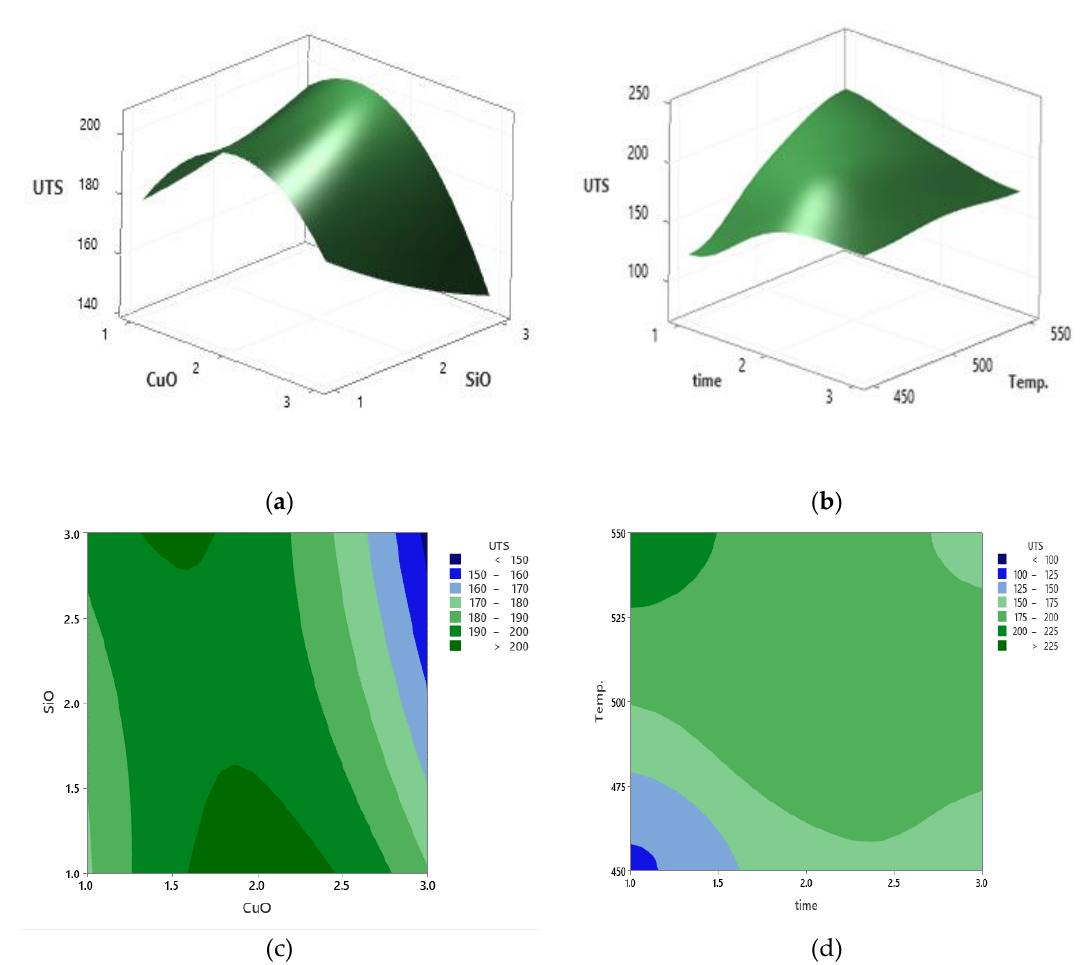
Figure 10. ( a ) Response surface plots of UTS vs. SiO 2 and CuO. ( b ) Response surface plots of UTS vs. temp, and time. ( c ) Contour plot of UTS vs. SiO 2 and CuO. ( d ) Contour plot of UTS vs. temp, and time.